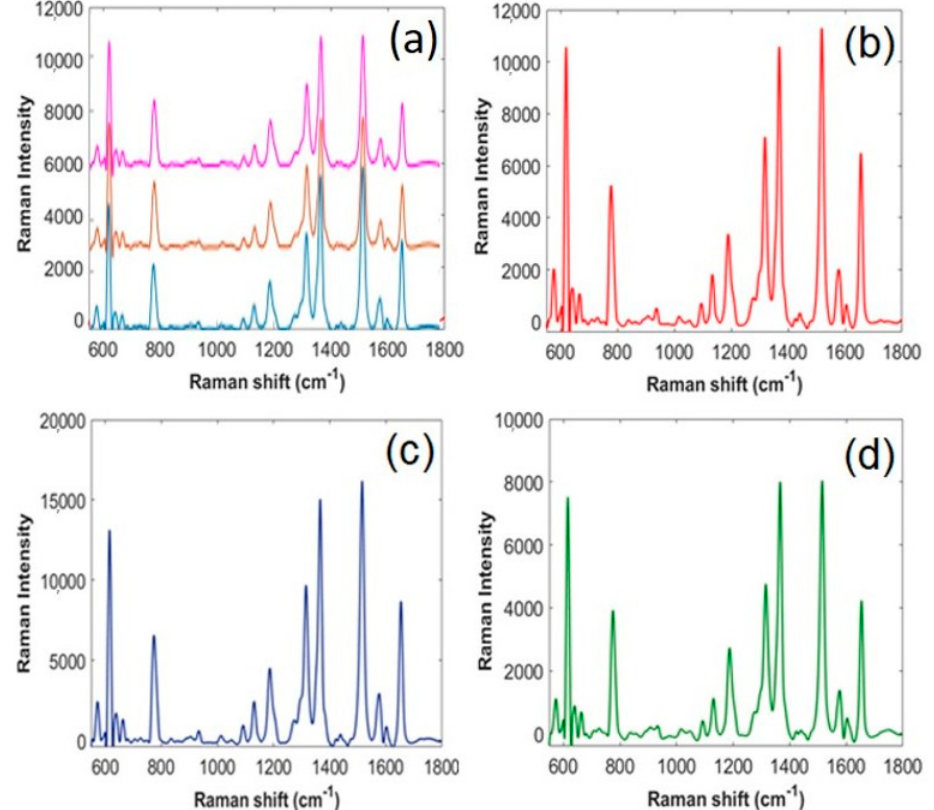
Figure 6. SERS spectra of 10 − 5 M R6G on different G-SERS substrates. ( a ) Uncoated dendritic substrate. ( b ) GO-coated dendrites (N = 25). ( c ) rGO-coated dendrites (N = 5). ( d ) GNP-coated dendrites (N = 1).